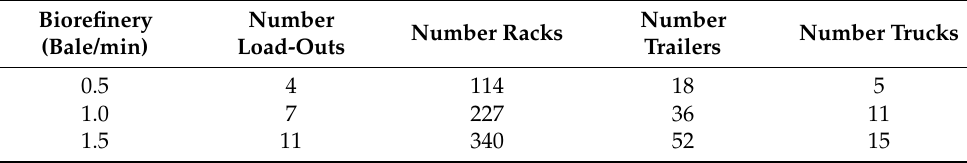
Table 6. Equipment specifications for different capacity